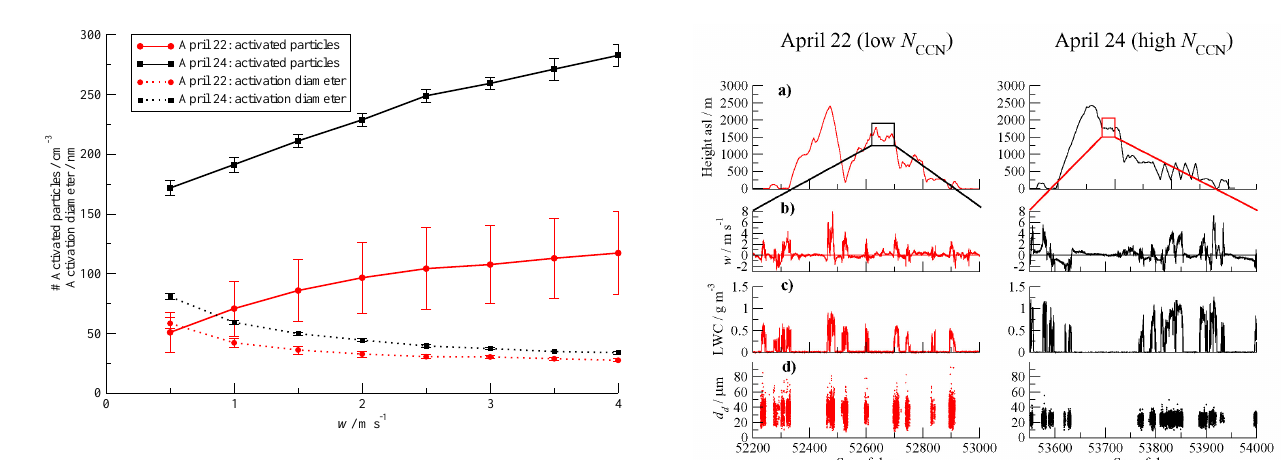
Fig. 9. Model results of activated aerosol particles and activation diameter as a function of updraft velocity w . The box model was initiated with observed aerosol conditions in the SCL on 22 and 24 April.